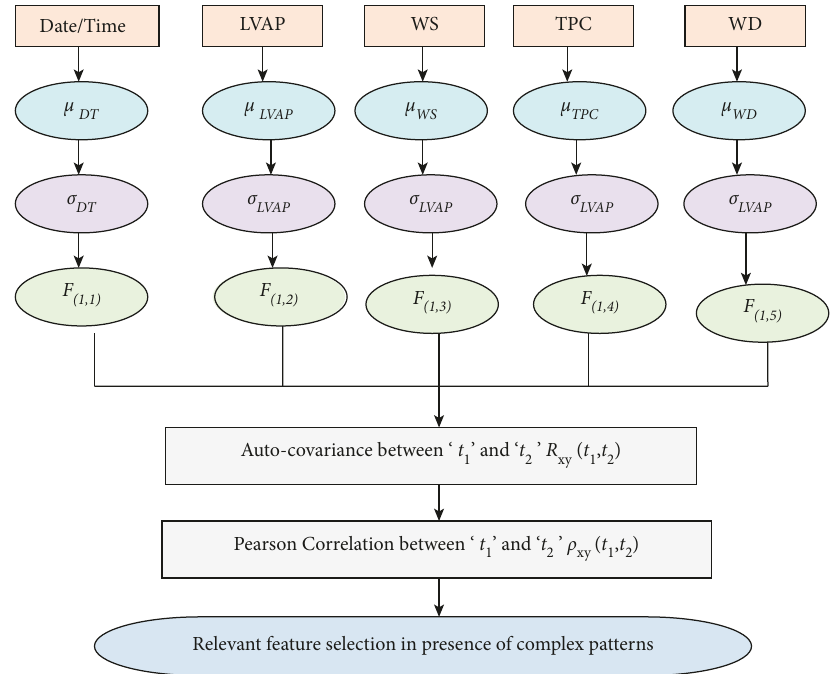
Figure 2: Structure of Pearson Autocovariance Feature Selection